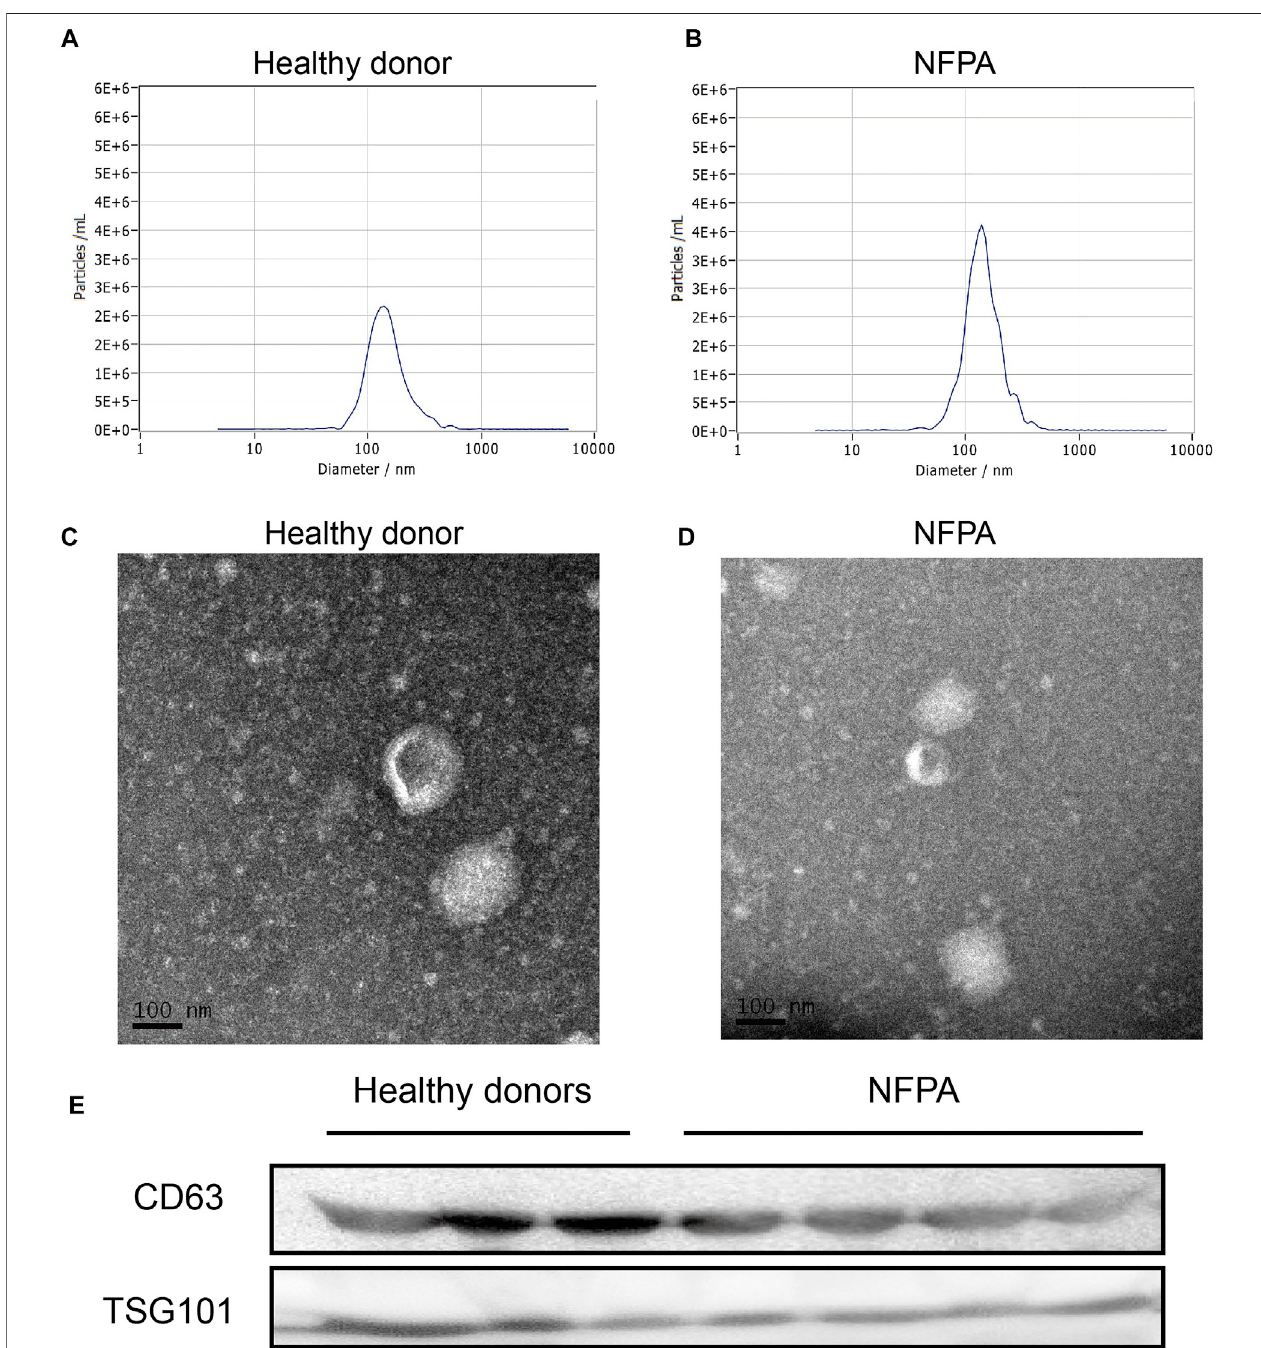
FIGURE1| Isolationandidenti fi cationofexosome.NTAdataindicatedthatthesizeofisolatedparticleswasmostlynanoscale (A,B) andpresentedaroundoroval shape with central cavity on TEM (C,D) . They also expressed the widely accepted exosome markers (CD63 and TSG101) in Western blotting (E) .